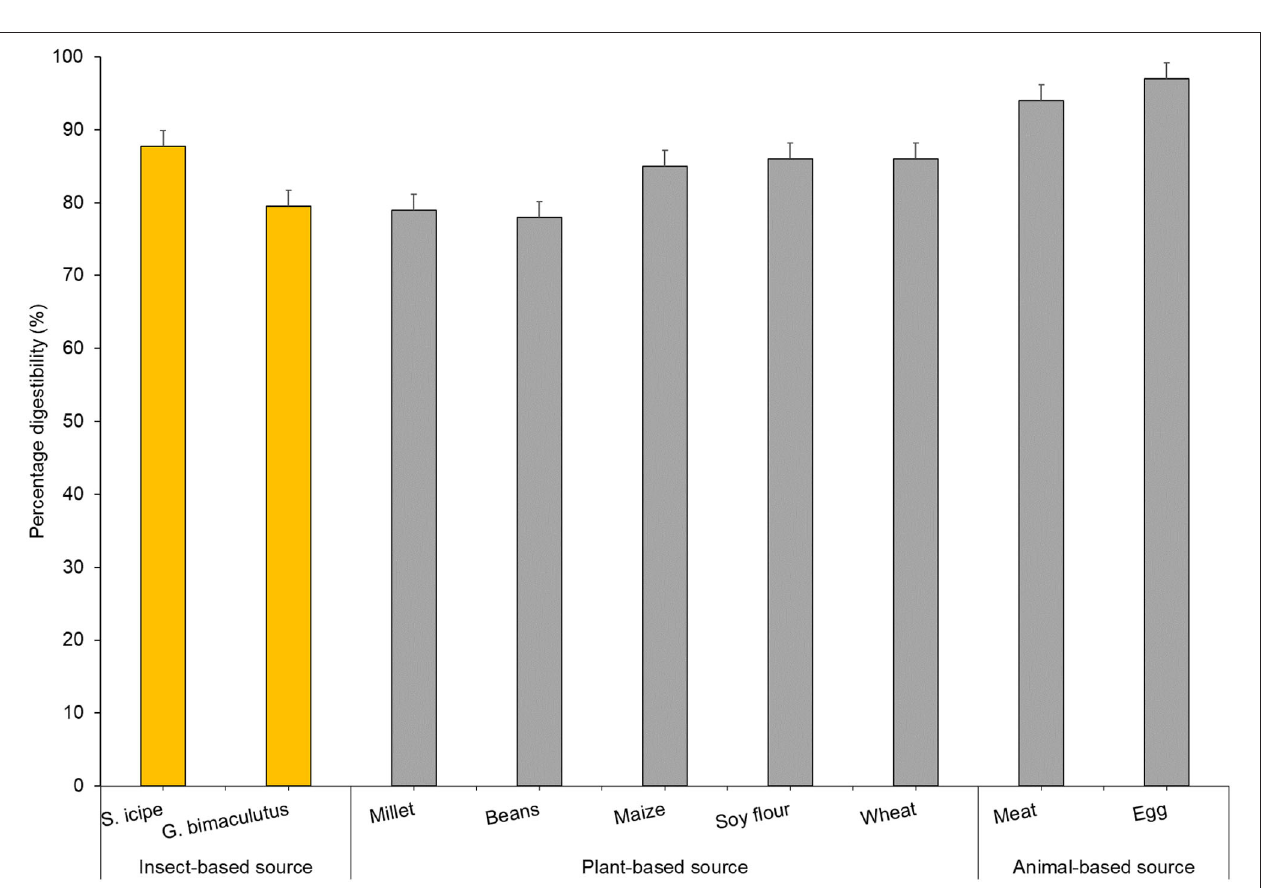
Frontiers in Nutrition |